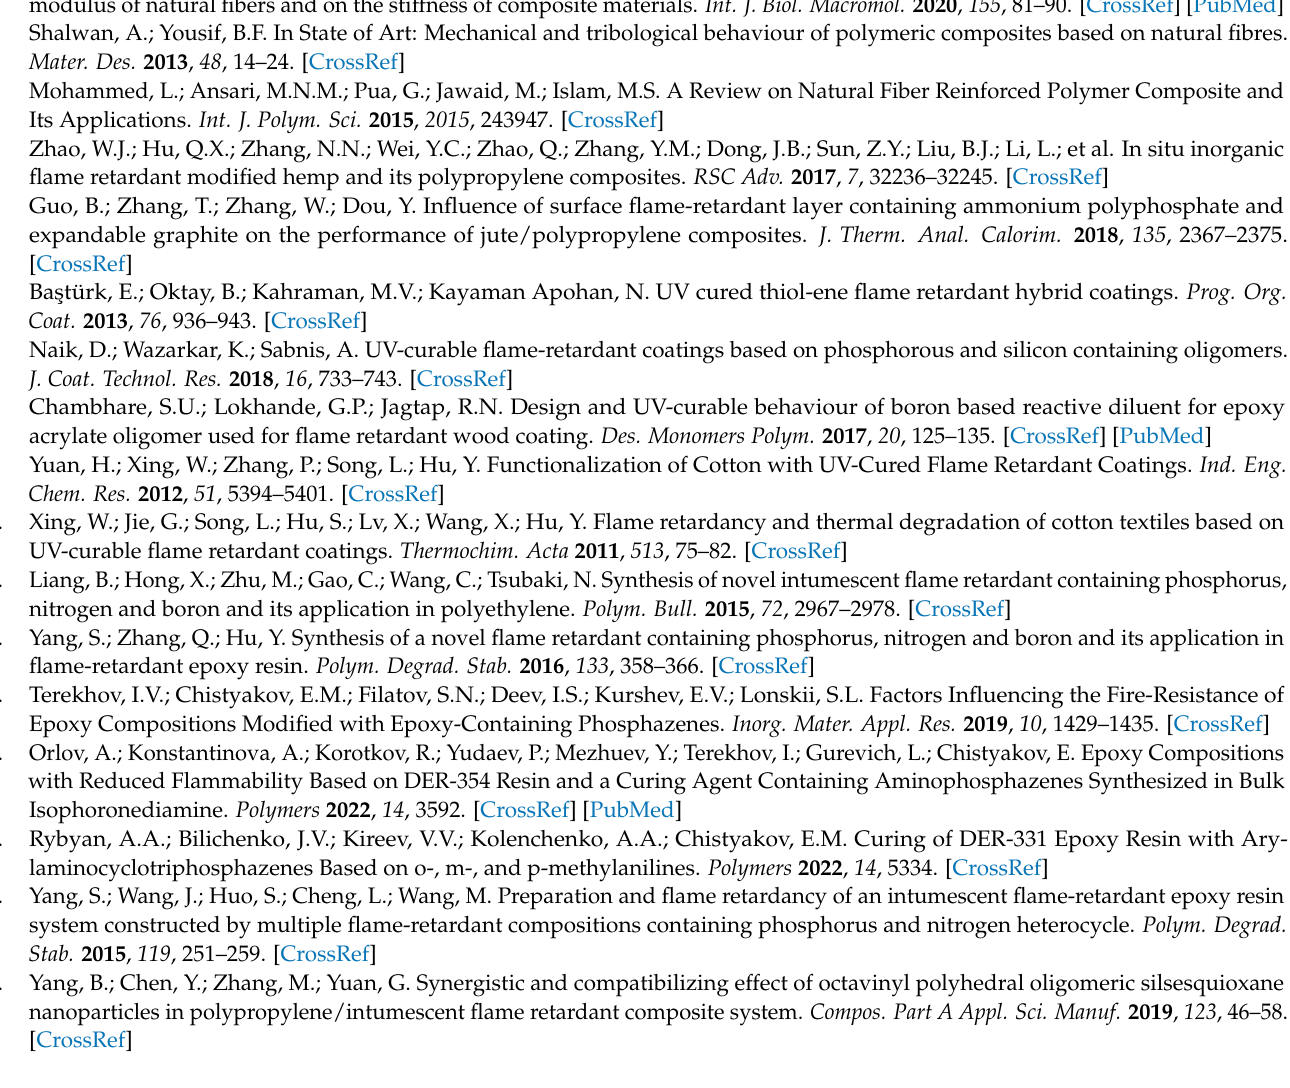
Table S1: Thermal properties of the FNFs and coated